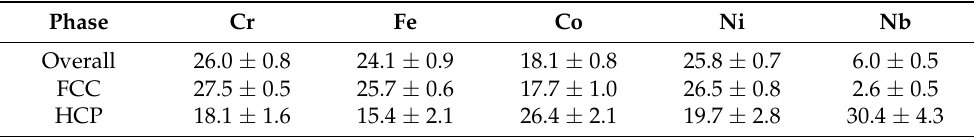
Table 1. Chemical compositions of the phases in the Cr 27 Fe 24 Co 18 Ni 26 Nb 5 alloy analyzed by SEM/EDS in atomic